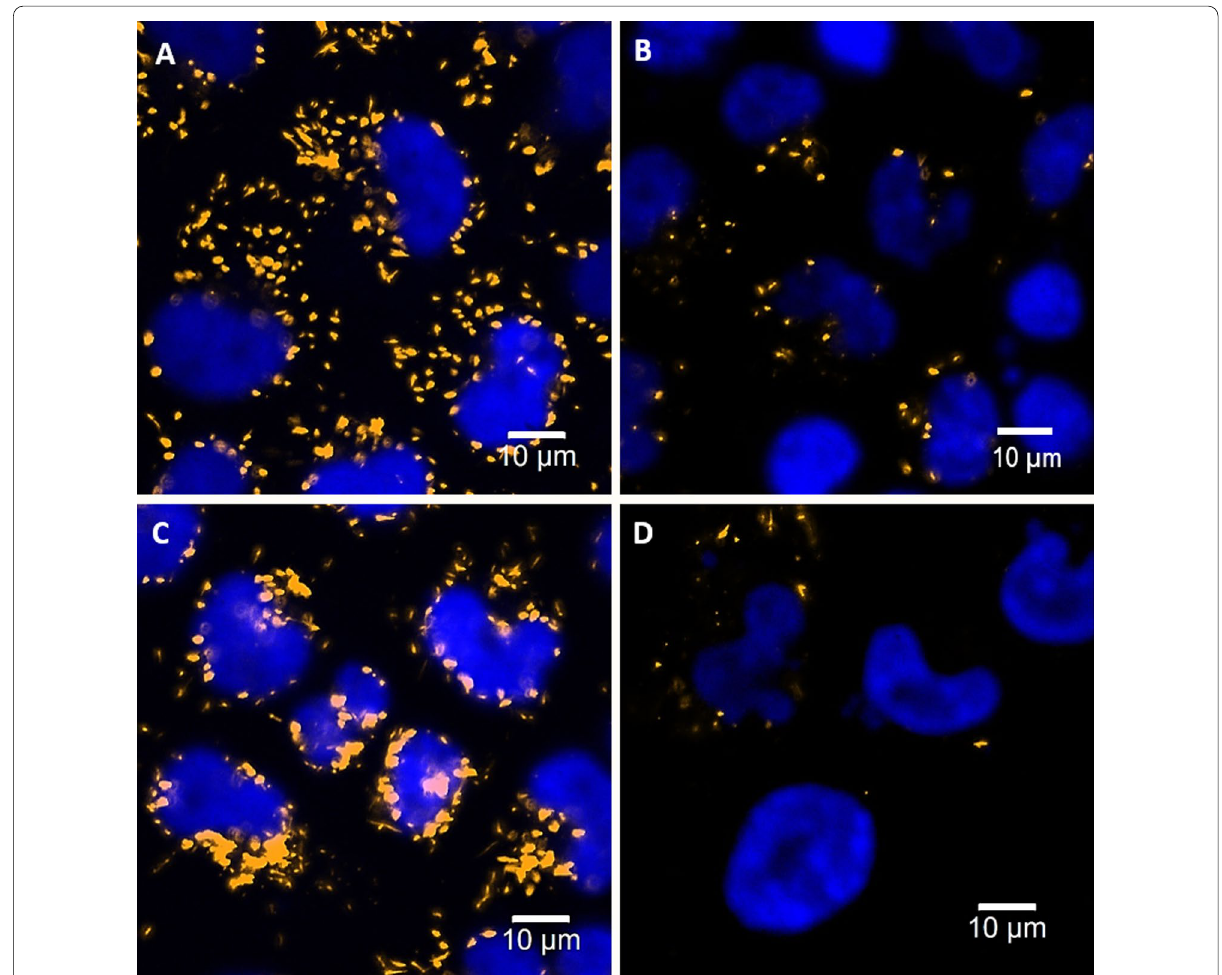
Fig. 4 Cell fluorescence images of LSCM for labeled activate mitochondria, 48 h after irradiation of 6 Gy Cs‑137 (magnification: the images of the controls without and with irradiation of Cs‑137, respectively. C and D are the images of the GNPs‑uptake cells without and with irradiation, respectively. Kit for mitochondria: MitoCapture ™ (yellow). Kit for nuclei: Hoechest 33,342